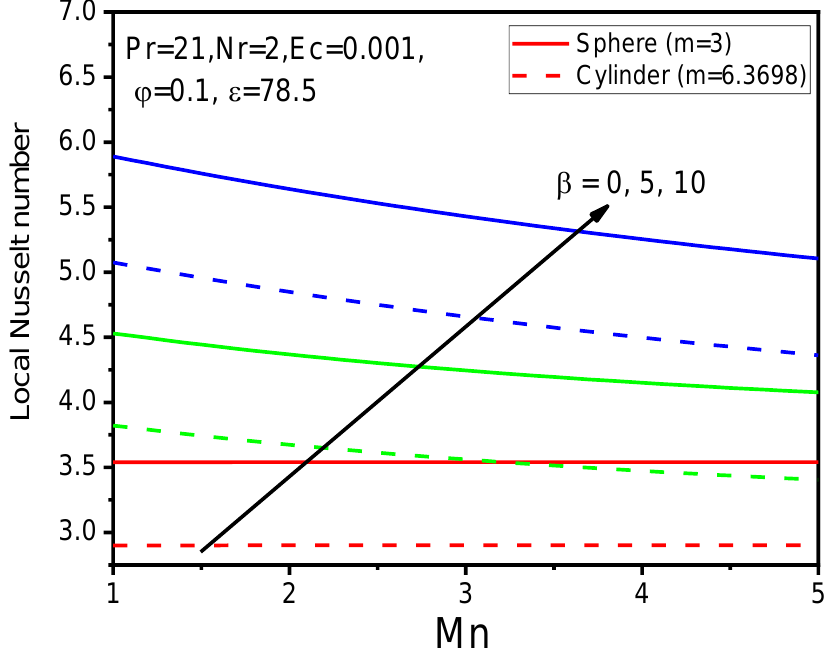
Figure 19. (Case b): Values of the skin friction coefficient for different values of β against Mn .